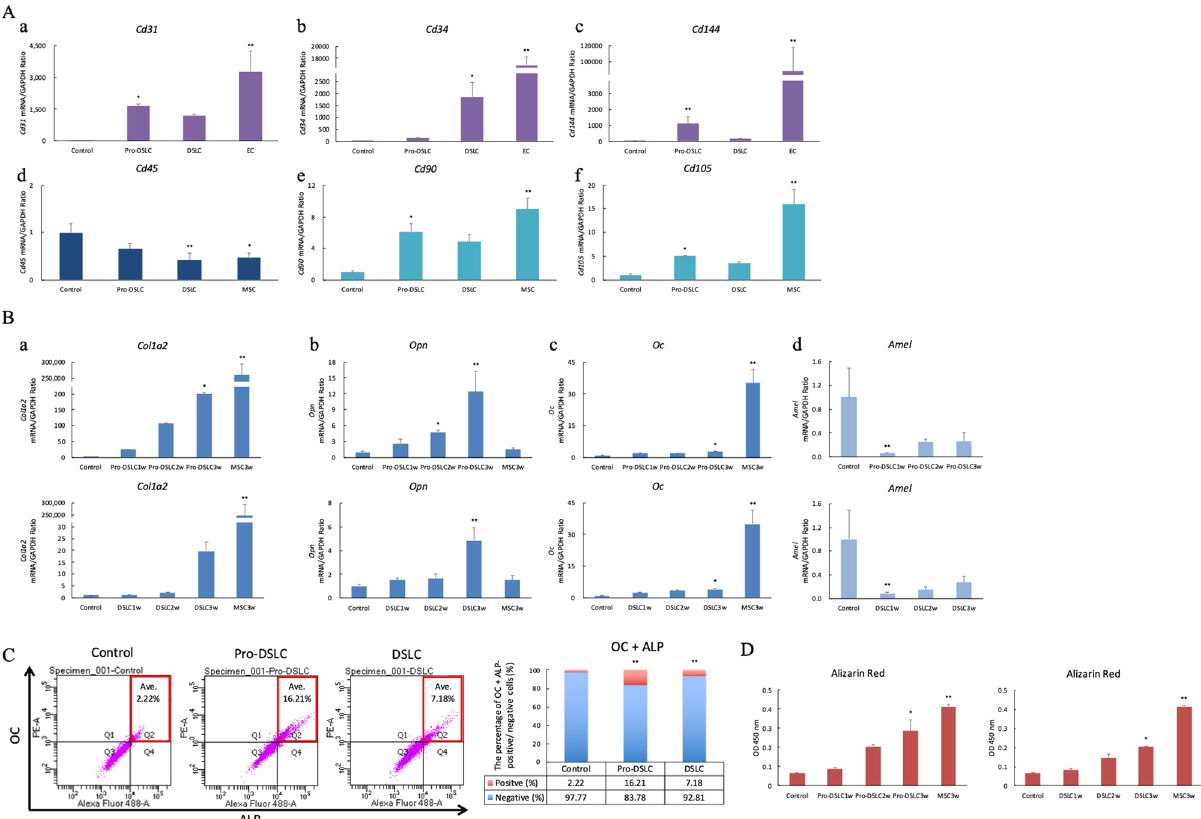
Figure 6. Graphs showing the differentiation of controls (ERM cells), Pro-DSLCs, and DSLCs into ECs, MSCs, and osteoblasts. The expression levels of Cd31 and Cd144 (endothelial cell markers) in Pro-DSLCs and ECs, and Cd34 (endothelial cell marker) in DSLCs and ECs cultured in the endothelial differentiation medium were significantly higher than those in the controls (** p < 0.01, * p < 0.05; Kruskal–Wallis test, n = 5; Aa – c ). The expression levels of Cd45 (mesenchymal stem cell-negative marker) in the DSLCs and MSCs were significantly lower than those in the controls (** p < 0.01, * p < 0.05; Kruskal–Wallis test, n = 5; Ad ). The expression levels of Cd90 and Cd105 (mesenchymal stem cell-positive markers) in the Pro-DSLCs and MSCs were significantly higher than those in the controls (** p < 0.01, * p < 0.05; Ae , f ). The mRNA expression levels of osteogenic markers Col1a2 in Pro-DSLCs and MSCs, Opn in Pro-DSLCs and DSLCs, and Oc in Pro-DSLCs, DSLCs and MSCs, cultured in osteogenic differentiation culture medium were significantly higher than those in the controls (** p < 0.01, * p < 0.05; Kruskal–Wallis test, n = 5; Ba – c ). Conversely, the significantly decreased mRNA levels of Amel (odontogenic marker) were observed in the Pro-DSLCs and DSLCs compared to those in the controls (** p < 0.01; Bd ). The expression of OC and ALP was evaluated using a flow cytometer ( C ). Flow cytometry revealed a significant increase in the number of cells stained with OC and ALP in the Pro-DSLCs and DSLCs when compared to those in the controls (** p < 0.01; χ 2 tests, n = 5). The calcification levels determined by Alizarin Red were significantly higher in the Pro-DSLCs, DSLCs, and MSCs than those in the controls (** p < 0.01, * p < 0.05; Kruskal–Wallis test, n = 5; D